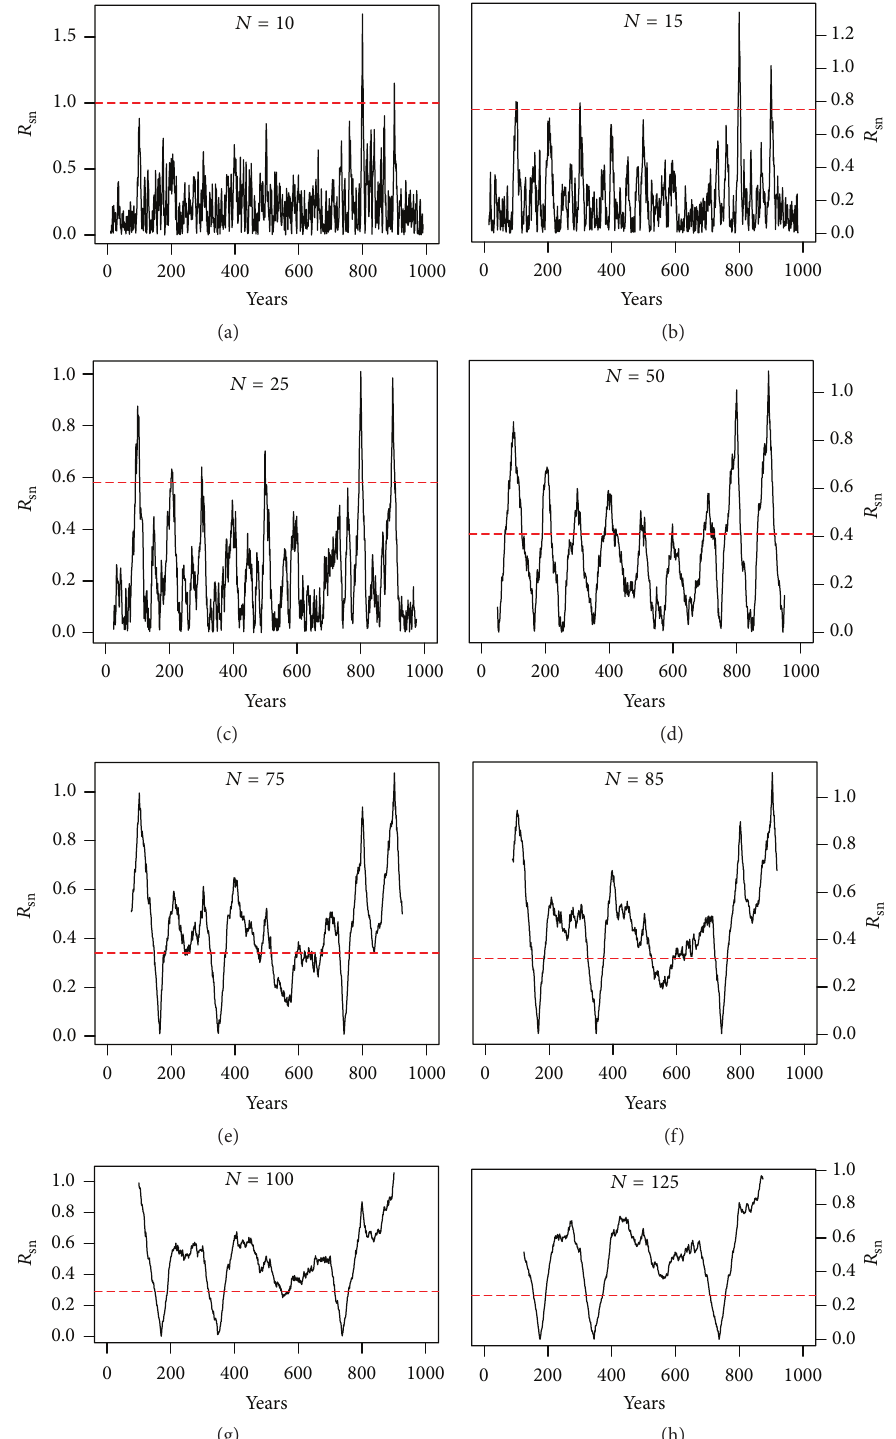
Figure 5: Abrupt changes in the artificial time series detected using different subseries